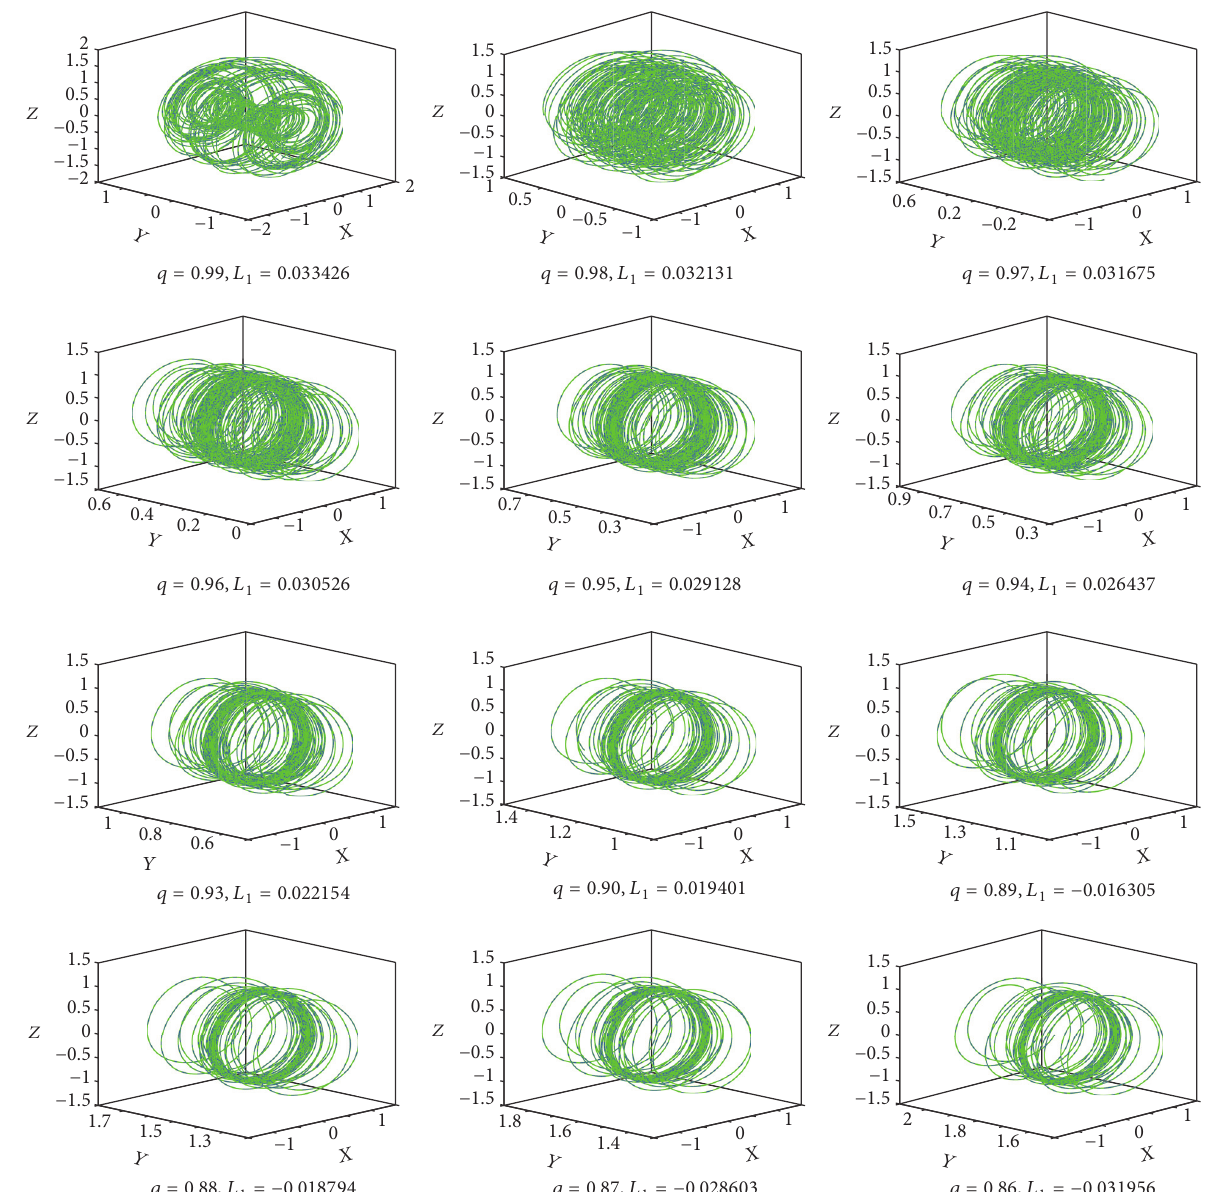
Figure 7: 3D state portrait ( 𝑋𝑌𝑍 plane) of FOMNE system for various fractional